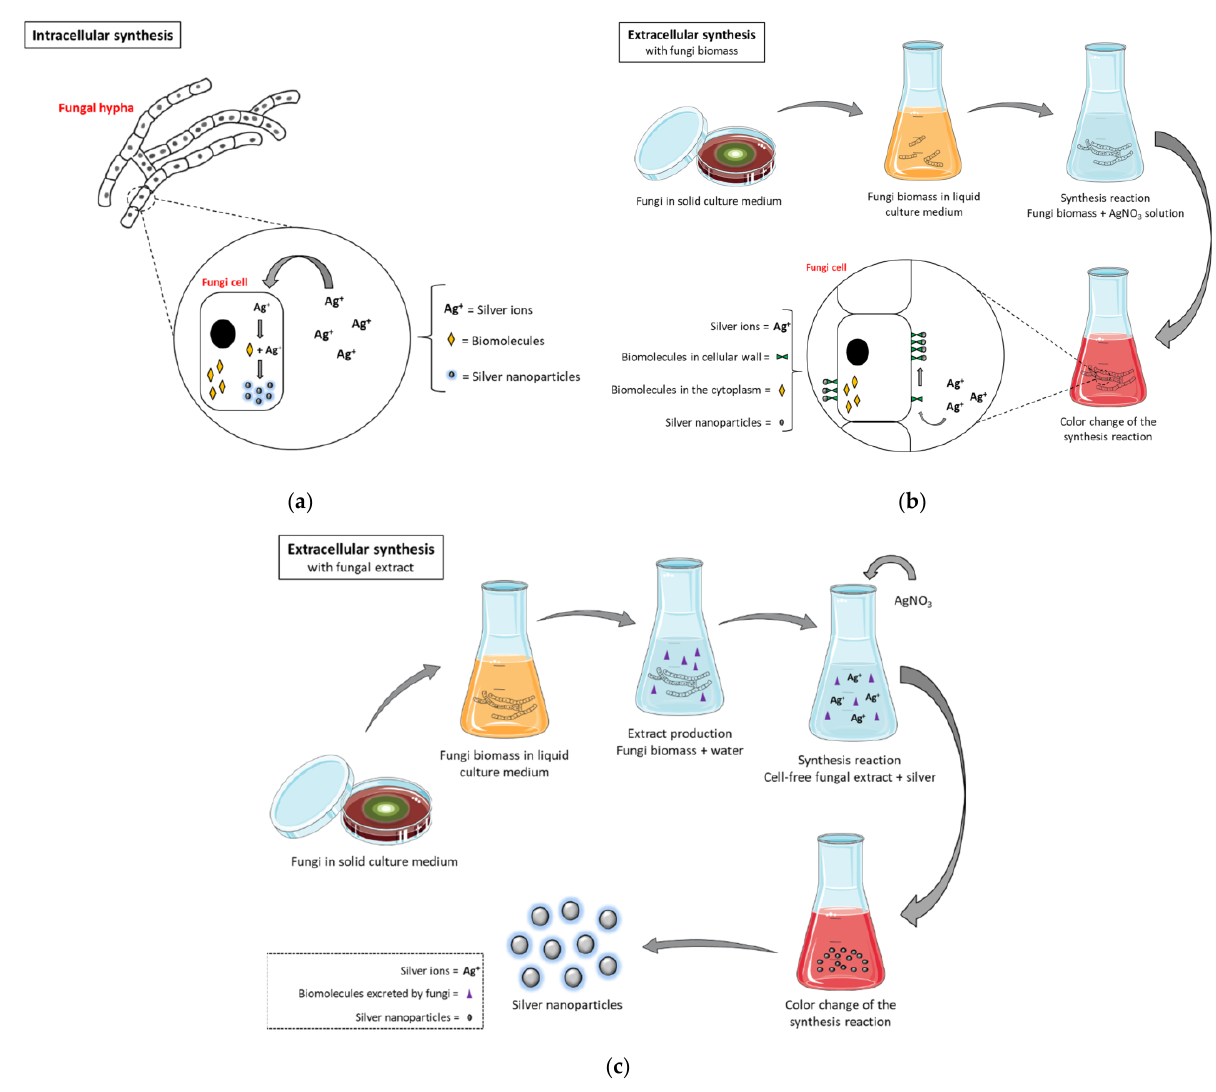
Figure 6. Intracellular biosynthesis of Ag nanoparticles using fungi ( a ), extracellular biosynthesis of Ag nanoparticles using fungal biomass ( b ), and extracellular biosynthesis of Ag nanoparticles using cell-free fungal extract ( c ). Copied from MDPI [99].